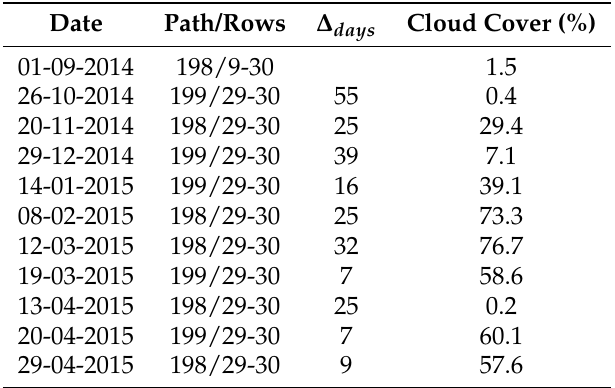
Table 2. Landsat8 imagery used for this